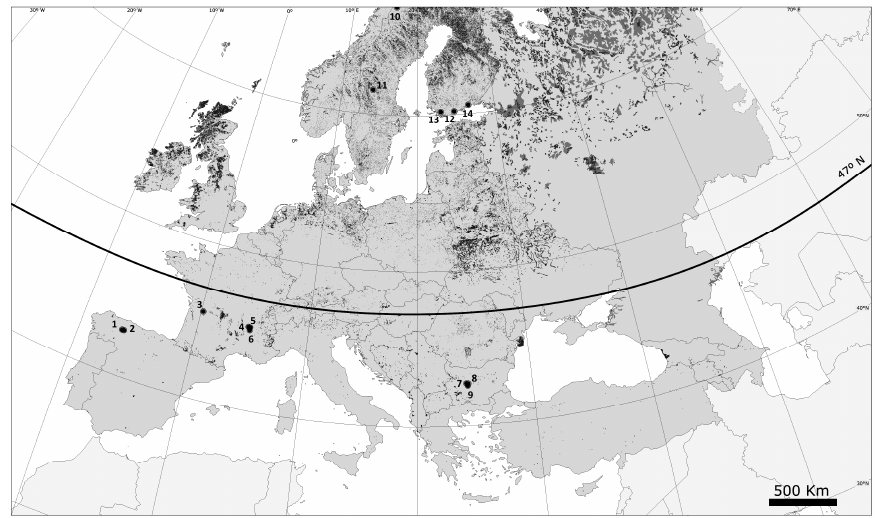
Figure 1. Distribution of peatlands in Europe, below the 47° N parallel the Southern Europe peatlands, in which diatoms have been used in paleoenvironmental reconstruction studies (see Table 1) (map modified from Tanneberg et al. [89]): (1) Villaseca; (2) La Mata; (3) Charente; (4) Le Verdier mire; (5) Virennes fens; (6) La Prenarde-Pifoy mire; (7) Bogdan-3; (8) Bogdan-6; (9) Shiligarka; (10) Stordalen mire; (11) Kräckelbäcken fen; (12) Reksuo; (13) Punassuo; (14) Munasuo.